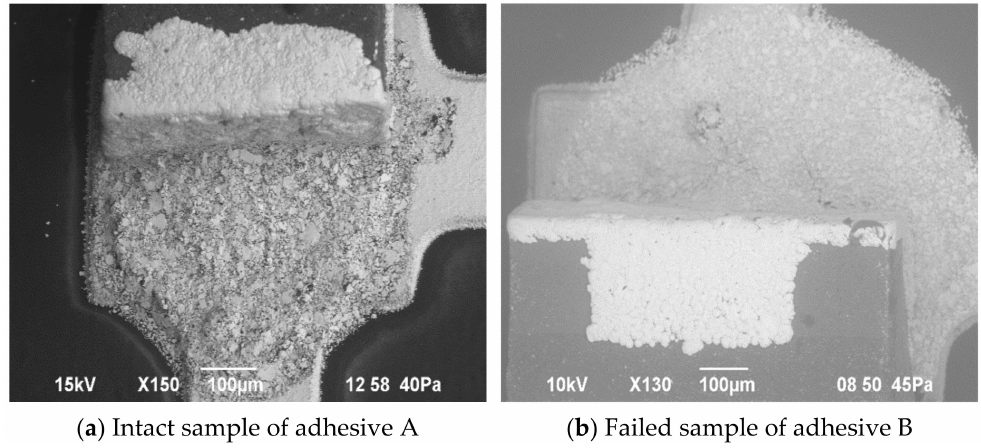
Figure 12. SEM pictures of conductively adhesive bonded SMDs after bending characterization.